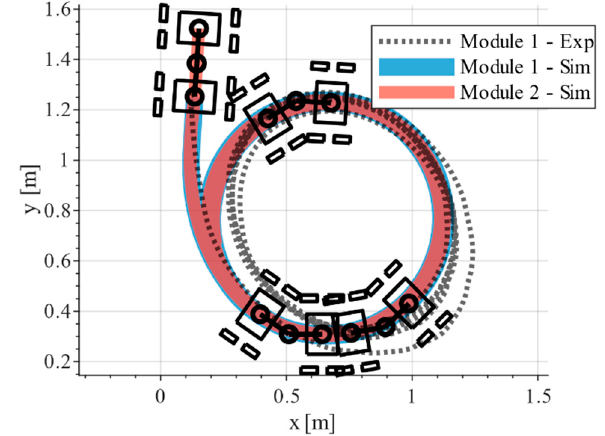
Figure 13. Position estimation of markers 1 and 2 fixed to a robot performing a circular trajectory. It is possible to note that two shifted circles appear, due to wheels slippage and other dynamic effects.